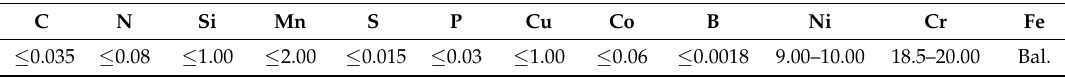
Table 1. Chemical composition of alloys 304L used, in wt. %.